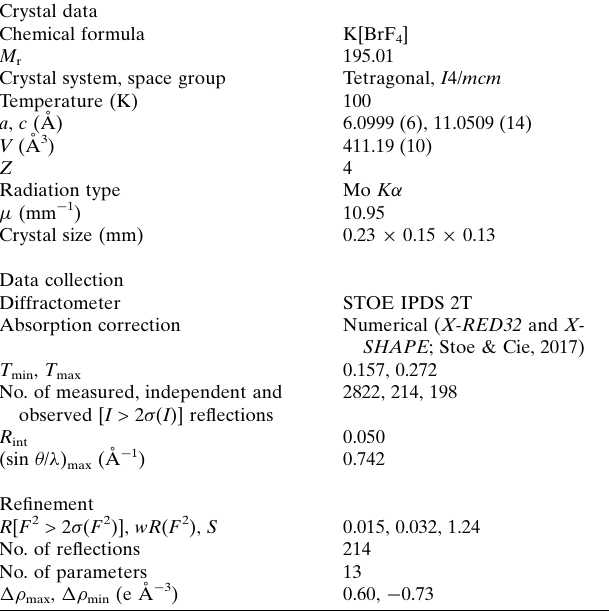
Crystal data Chemical